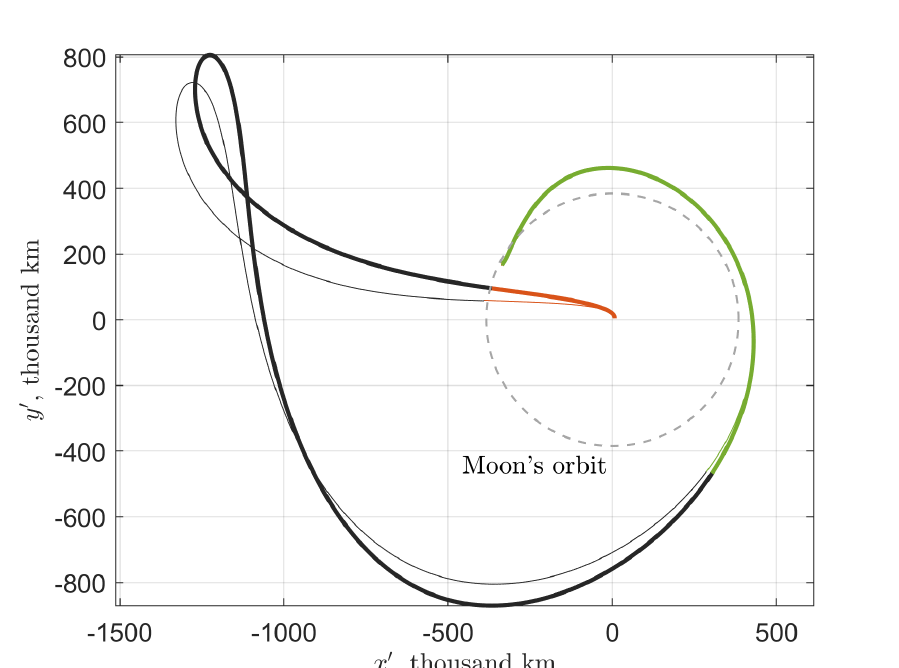
Figure 21. A sample SALT trajectory of the first type (no flyby): the patched three-body approximation (thin) and upon adaptation to the BR4BP (bold). The segments of the adapted trajectory corresponding to the departing, arriving, and exterior legs, are colored the same (red, green, and black, respectively). In the course of adaptation, the TLI impulse has increased from 3193 m/s to 3194 m/s. The burn phase has changed from 97.35 deg to 103.01 deg. The apogee TCM of 12.7 m/s has been added.